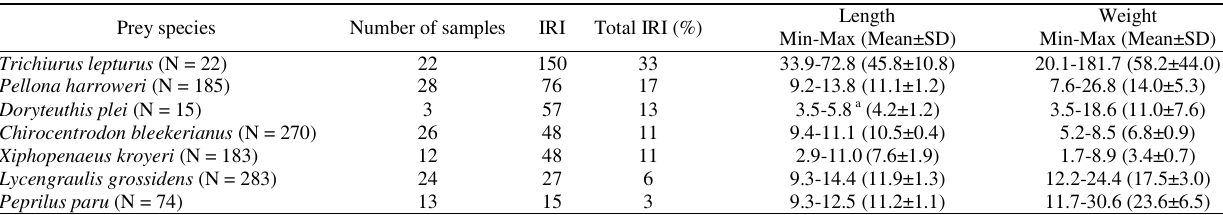
Table 1. Sample size, index of relative importance (IRI), total length (cm) and weight (g) of the prey species of Trichiurus lepturus in northern Rio de Janeiro State, Brazil, to proximate-composition and caloric value analysis. N = number of specimens for the composite samples, a mantle